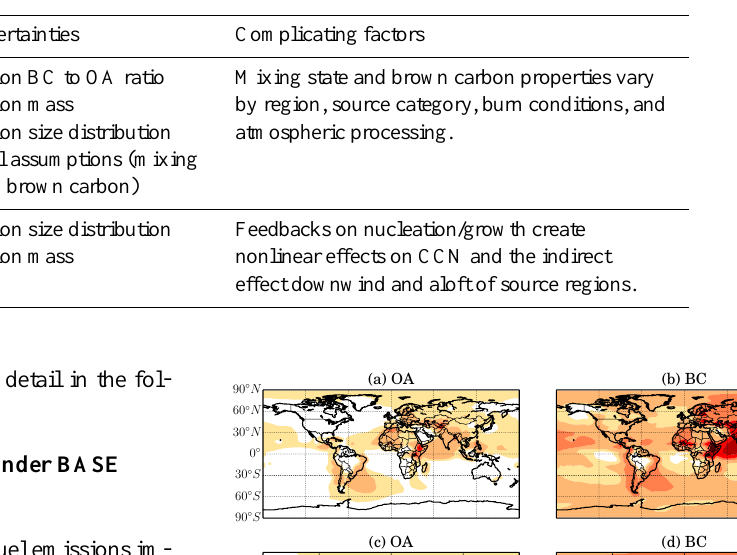
Table 5. Overview of key uncertainties and complicating factors that drive the variability in the direct radiative effect and cloud-albedo aerosol indirect effect.